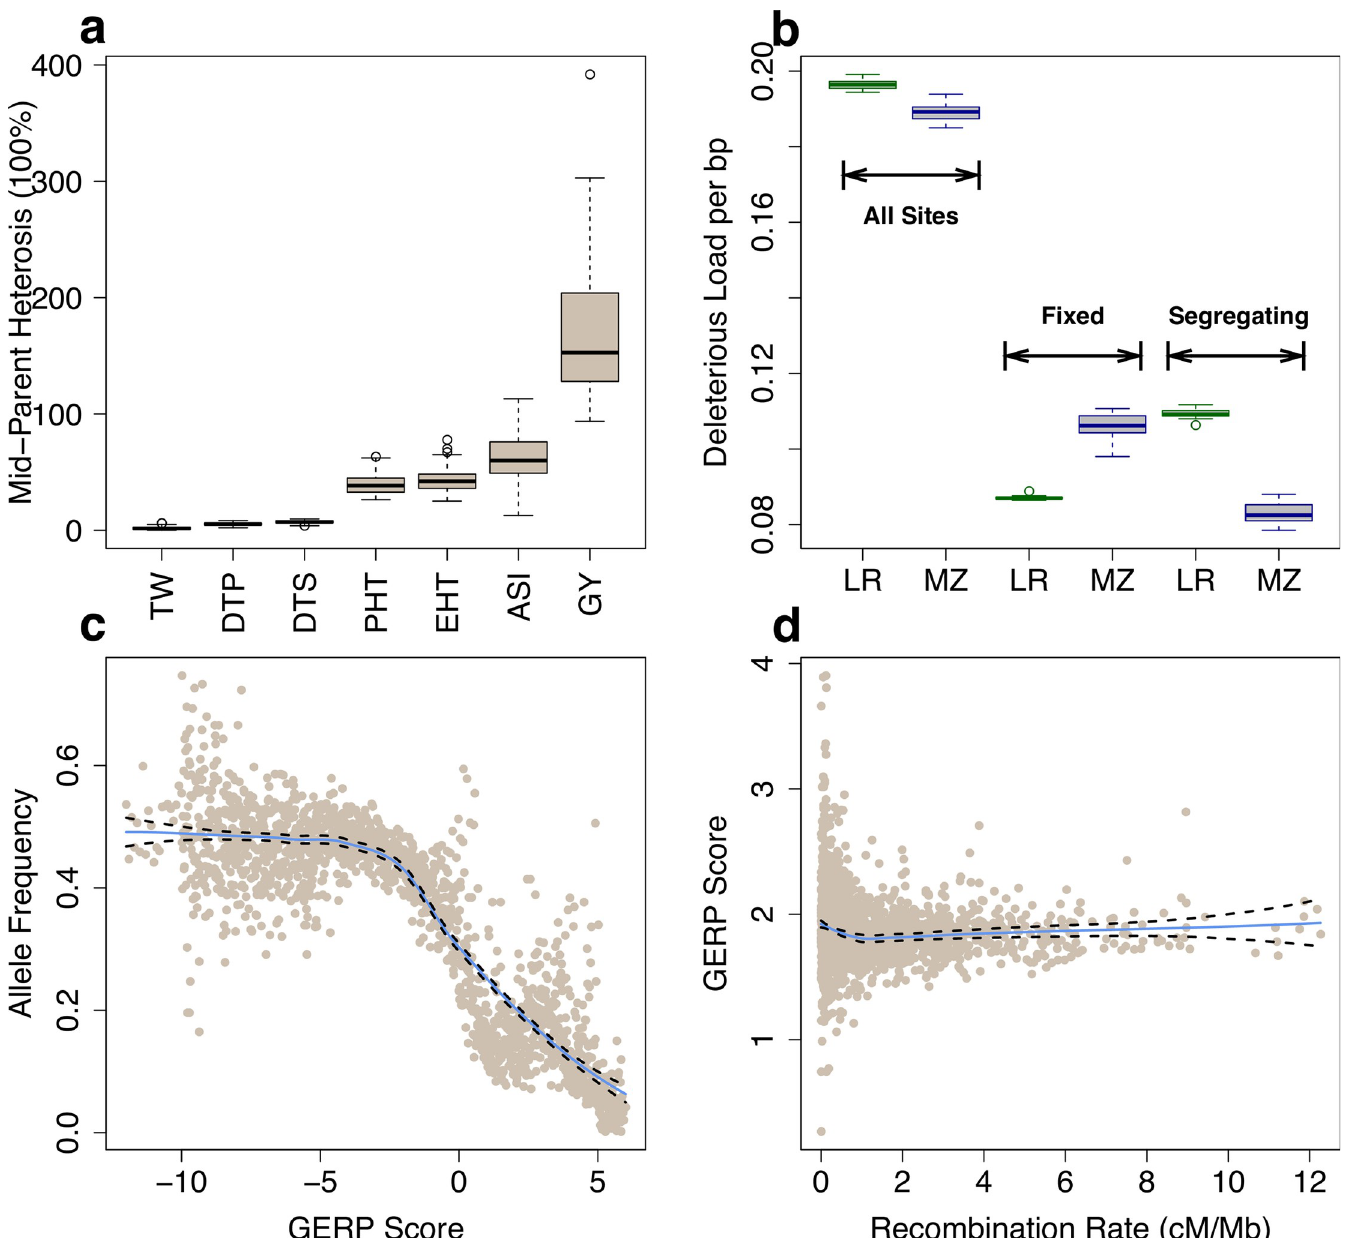
Fig 1. Heterosis and deleterious variants. ( a ) Boxplots (median and interquartile range) of percent mid-parent heterosis (MPH). ( b ) Proportion of deleterious alleles in landraces (LR, green) and elite maize (MZ, blue) lines. ( c ) The allele frequency of the minor alleles in the multi-species alignment in bins of 0.01 GERP score (including GERP < = 0 sites). ( d ) The mean GERP score for putatively deleterious sites (GERP > 0). Each point represents a 1 Mb window. In ( c ) and ( d ) the solid blue and dashed black lines define the best-fit regression line and its 95% confidence interval.